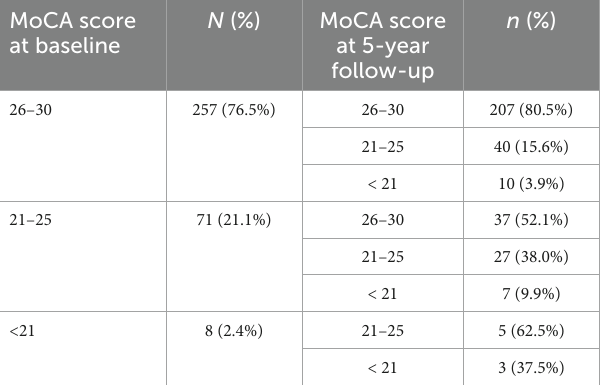
TABLE 4 Global cognitive function fluctuation in the early stage of newly diagnosed Parkinson’s disease (PD; less than 2 years) evaluated by changes in MoCA scores at baseline and 5-year follow-up. MoCA score at baseline